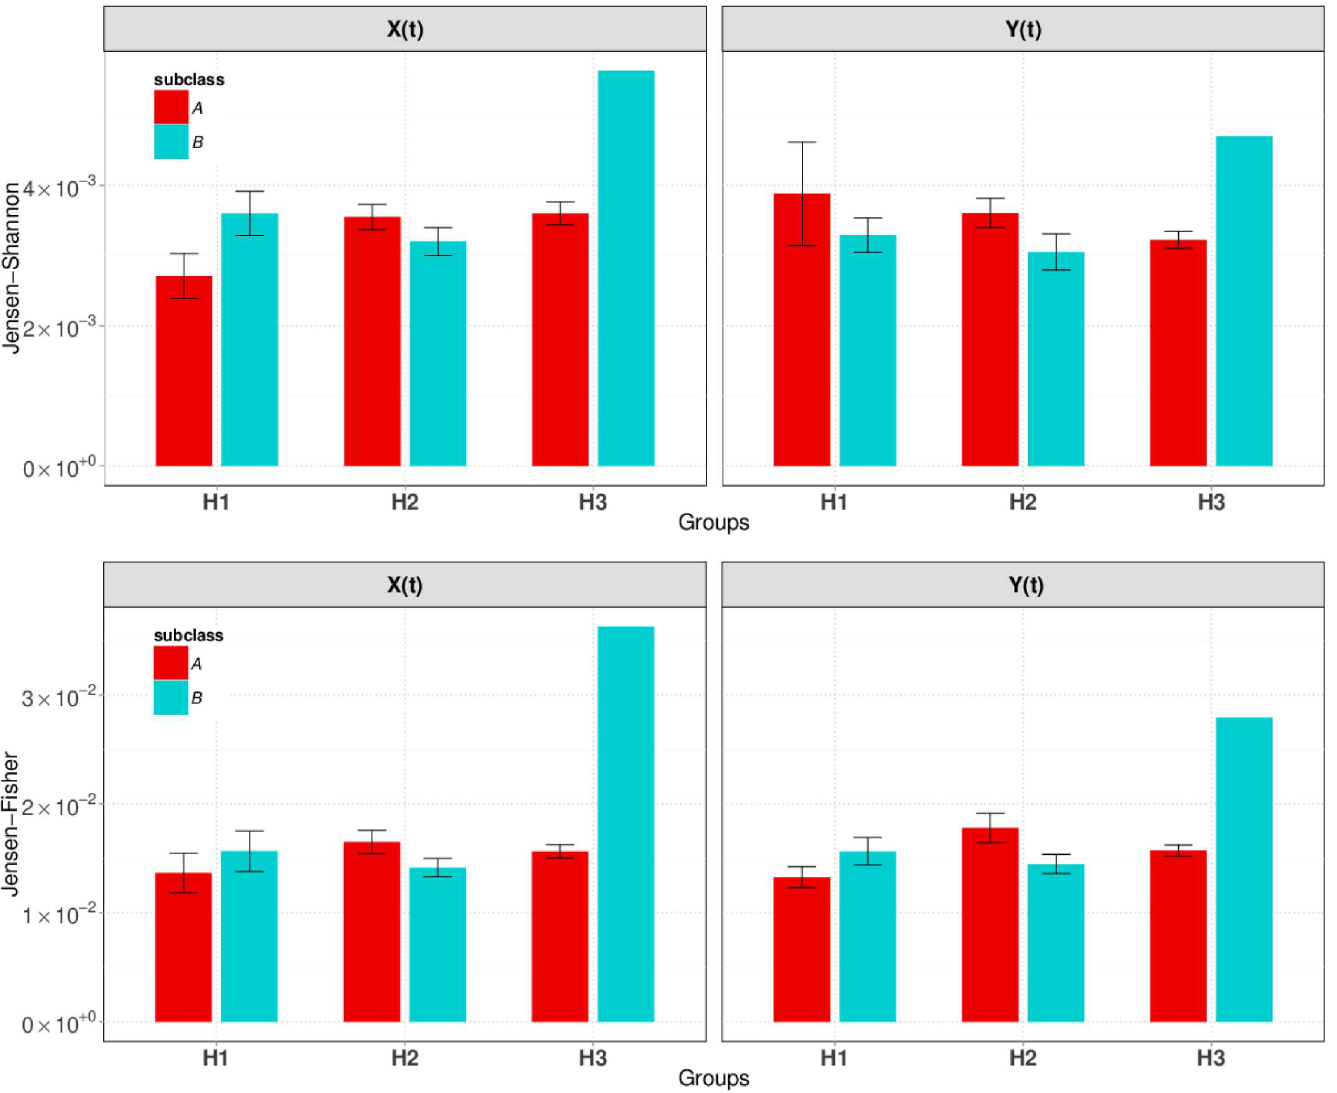
Fig 7. Global Jensen-Shannon (top) and local Jensen-Fisher (bottom) measuresof instability in genuine signatures. Bars show the mean, and lines show the standard error over the subjects. The standard error of H3B is not plotted becausethere are only two subjectsin this